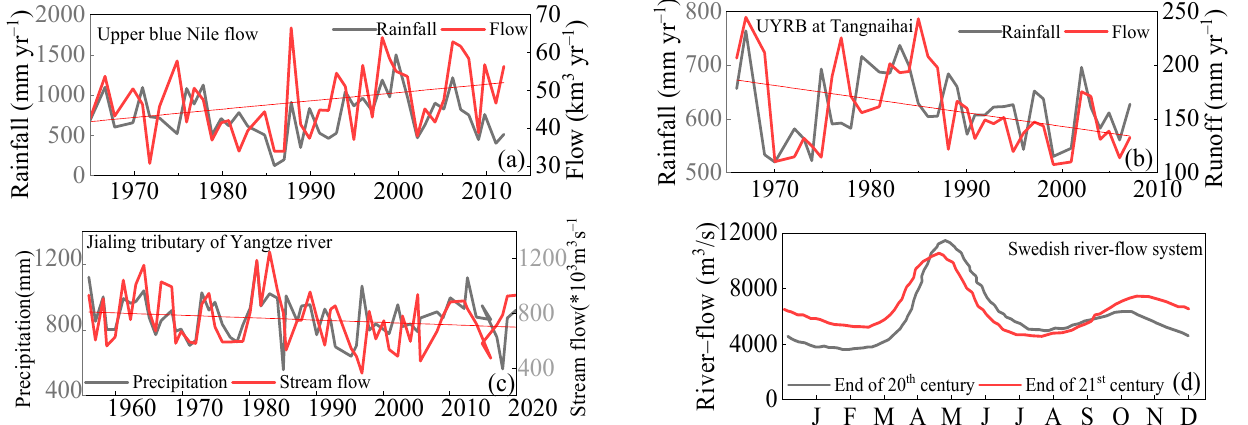
Figure 9. ( a ) Yearly rainfall time series based on a weighted average of rainfall stations and annual stream-flow time series averaged between June and May. ( b ) Yearly changes of rainfall and runoff in 1966–2009. ( c ) Yearly changes of precipitation and streamflow in 1965–2020. ( d ) Projected climate change (using a climate model ensemble) for 20th and 21st centuries.